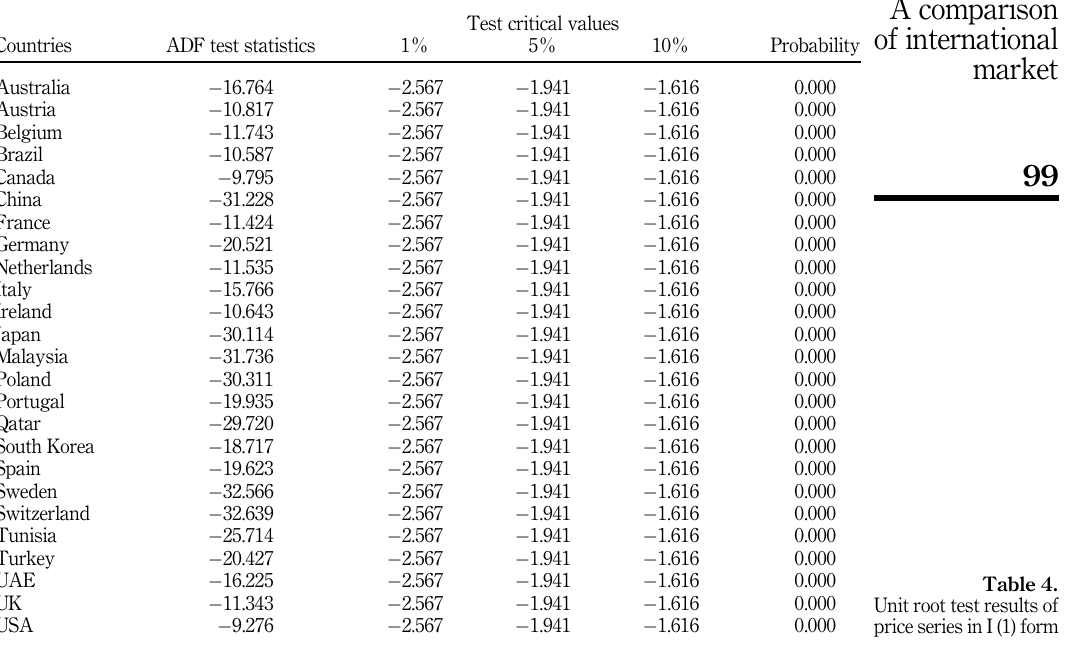
Table 4. Unit root test results